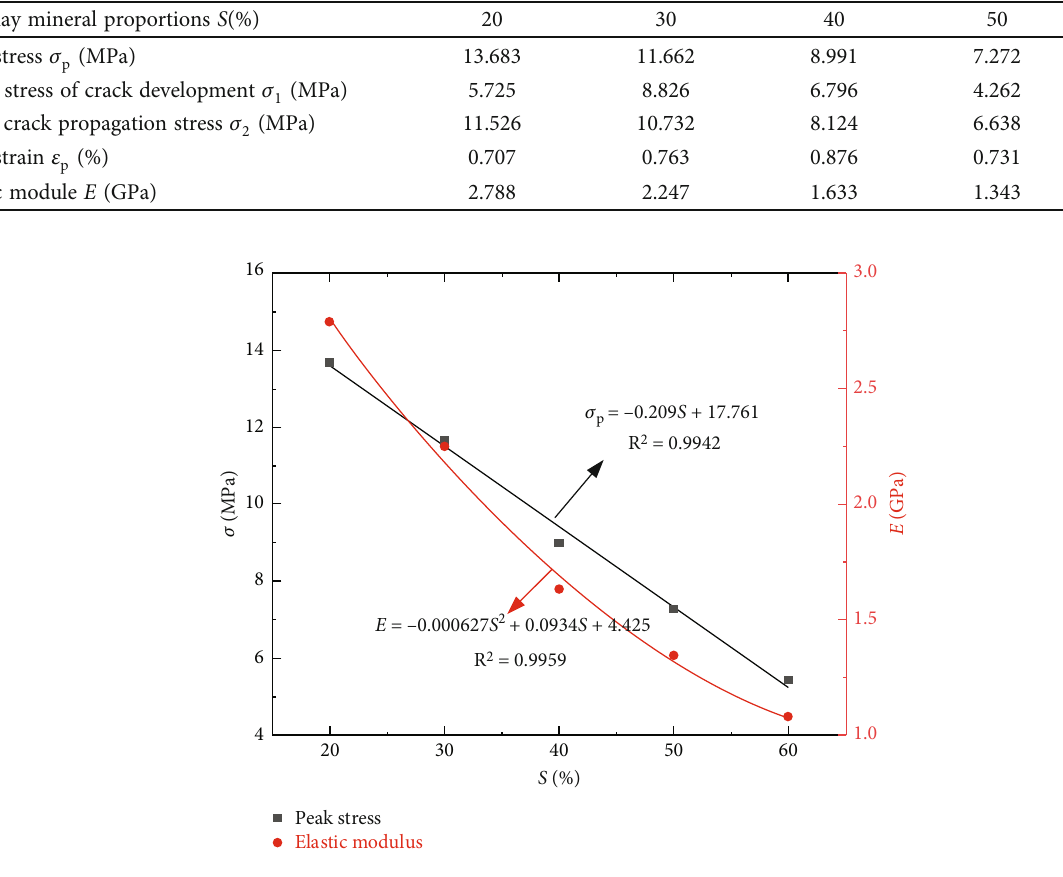
Figure 12: Variation of the peak stress and elastic modulus.